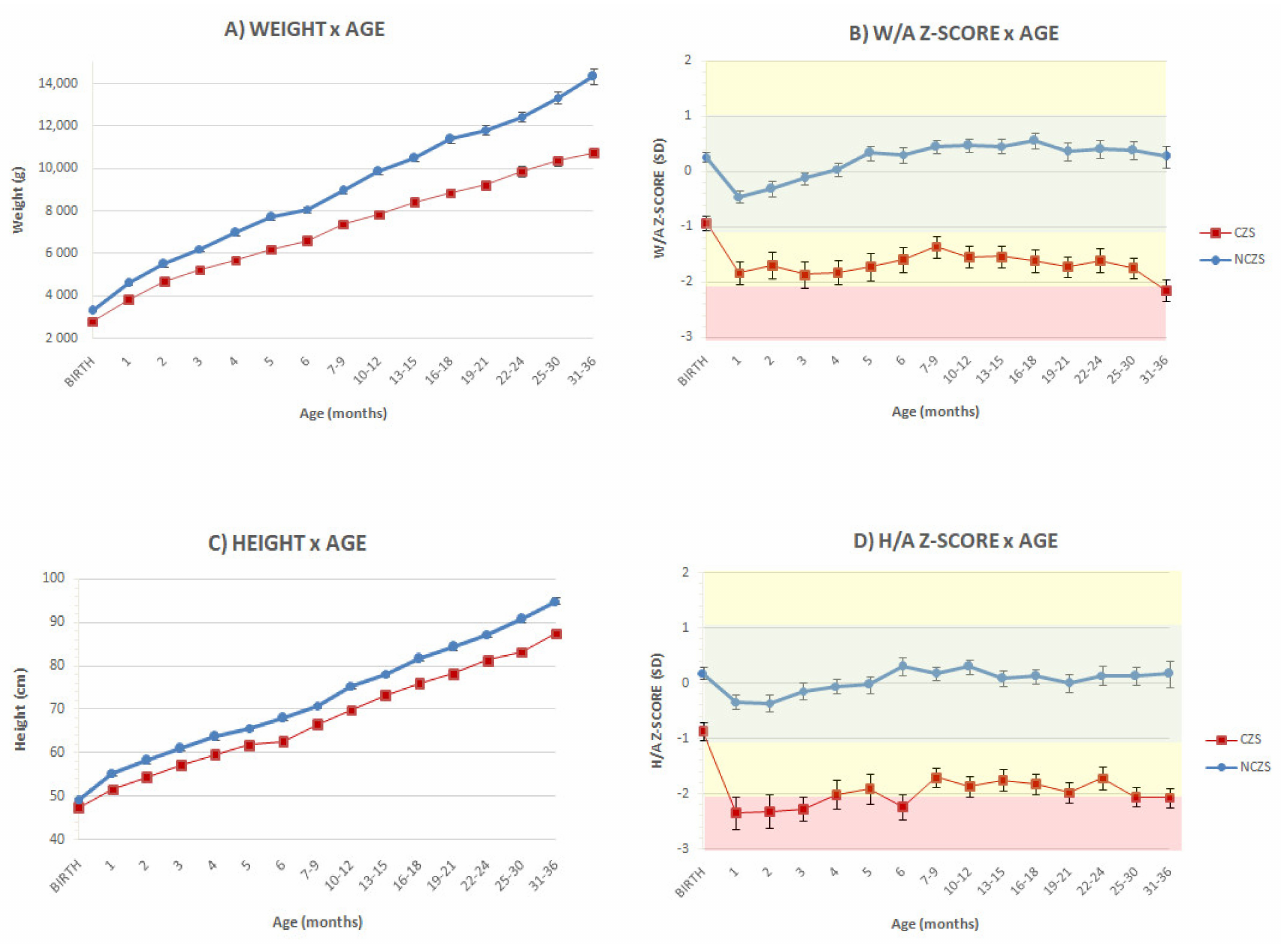
Figure 2. Weight and height absolute values and z-score means for age follow-up: CZS versus NCZS. Graphs compare ( A ) weight for age, ( B ) weight for age z-scores, ( C ) height for age and ( D ) height for age z-scores, based on WHO Growth Standards. W/A represents weight for age; H/A represents height for age; CZS: congenital zika syndrome; NCZS: not congenital zika syndrome. Bars represent standard